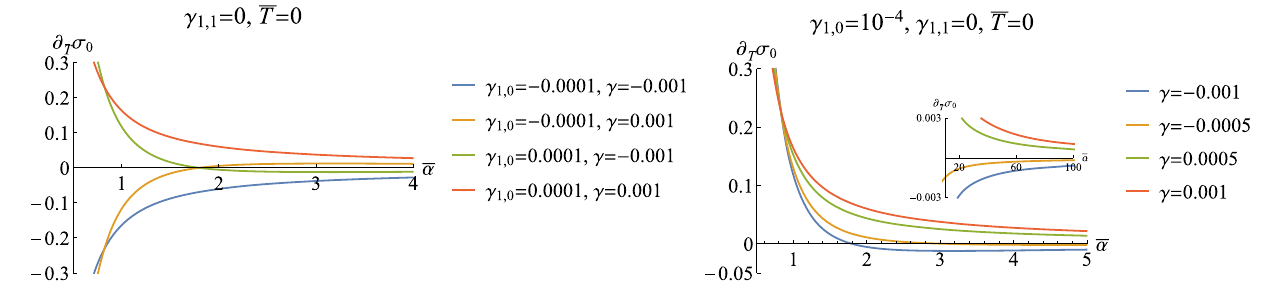
σ ¯ α at zero temperature Fig. 5 ∂ ¯ 0 as a function of T ment entropy and the butterfly effect close to QCP as